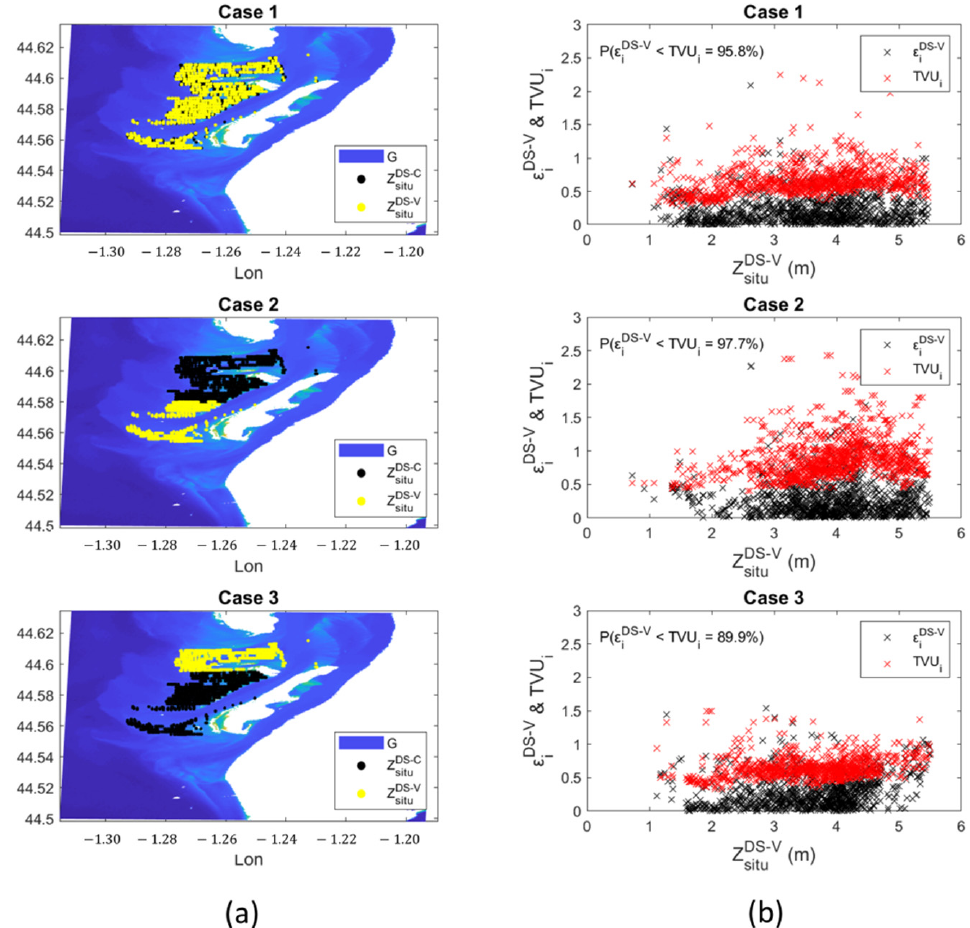
Figure 11. ( a ) Field bathymetry data point location associated with three contrasted spatial distribution of DS-C and DS-V (case 1: homogeneous distribution; case 2 and case 3: geographic segmentation) for the 2017 dataset. ( b ) Comparison between values of absolute error ε DS − V i (m), and total vertical uncertainty, TVU i (m), computed for each observation of DS-V for case 1, case 2 and case 3.